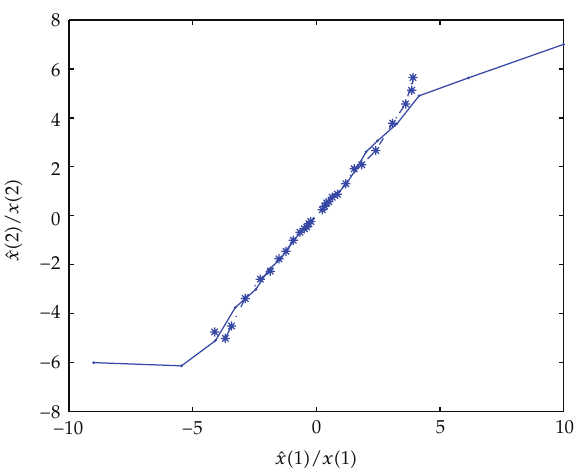
Figure 1: The state and estimator